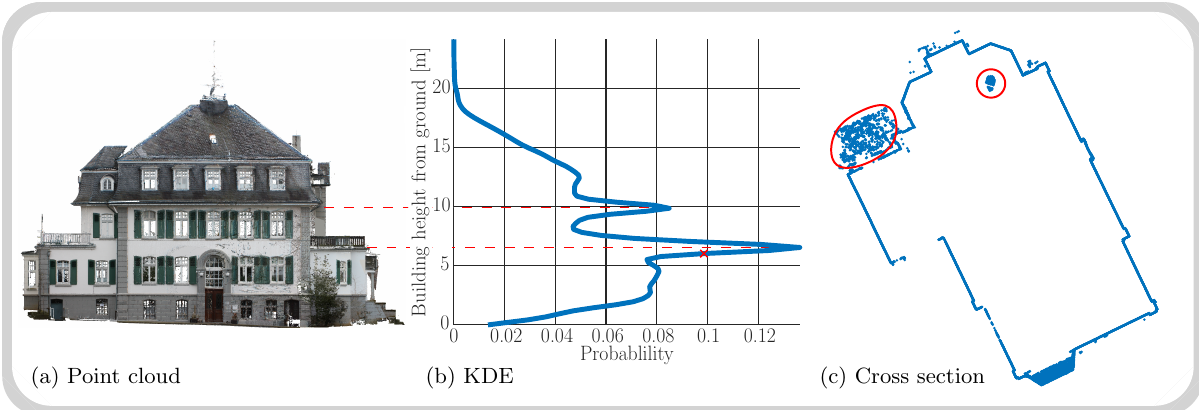
Figure 2: Automatic determination of the suitable height for a cross section exemplified by the building E STATE . Based on the 3D point cloud, a one-dimensional, z-directional, probability density function (PDF) is computed, provided by a kernel density estimator (KDE). This is used as a prior for the selection of a cross-section to be chosen. The red cross in the probability density function is the selected height of h c of our approach. The red outlines of the cross section highlight areas with many outliers as vegetation or points inside the building.